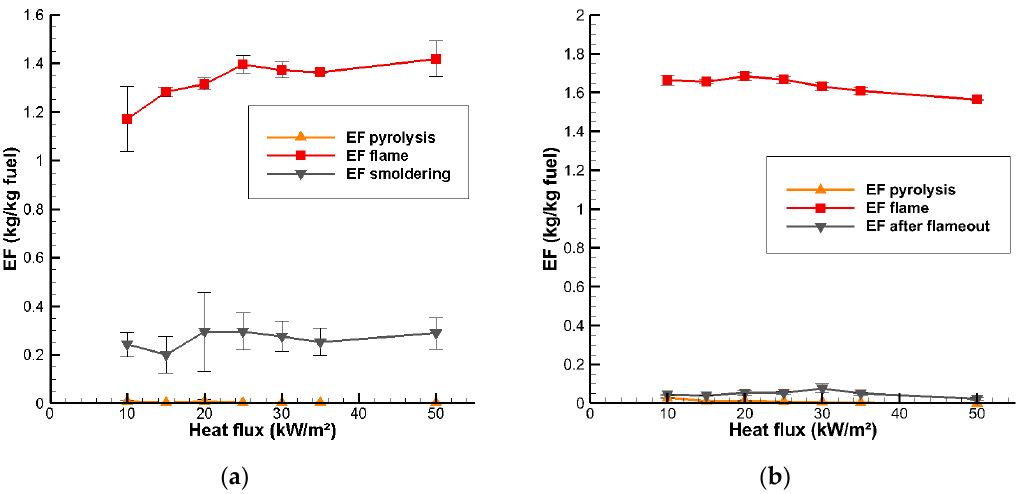
Figure 12. EF for CO 2 for an imposed heat fl ux ranging from 10 to 50 kW/m 2 for ( a ) wood and ( b ) thermoplastic samples.